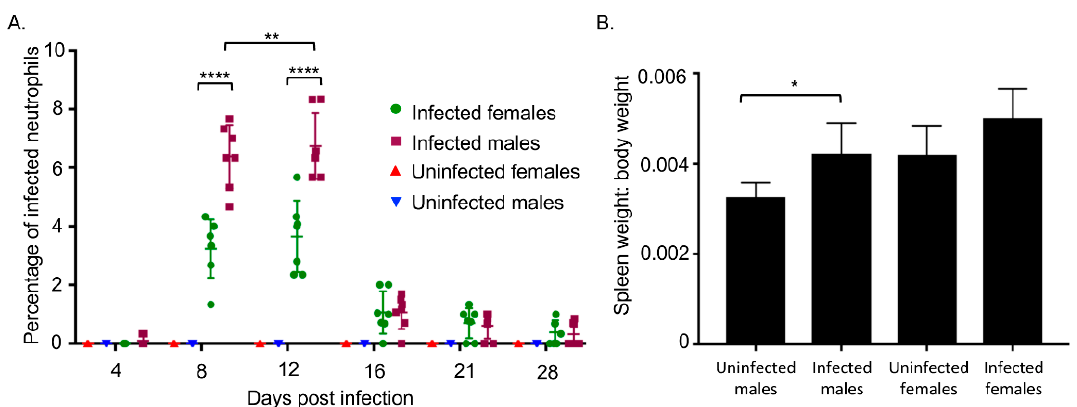
Figure 2. A. phagocytophilum infected male mice have higher percentages of peripheral blood neutrophils harboring morulae and greater degrees of splenomegaly than infected female mice. Male and female C57Bl/6 mice were intraperitoneally injected with A. phagocytophilum bacteria. ( A ) Peripheral blood smears were microscopically examined for neutrophils that contained morulae. Each dot corresponds to the mean percentage of infected neutrophils determined from counting a total of at least 300 neutrophils from three separate blood smears per mouse. Error bars correspond to the mean ± standard deviation of the percentages determined for all seven mice per group. Data are representative of two experiments with similar results; ( B ) On day 28, the mice were euthanized, the spleens were harvested, and the spleen-to-body weight ratios were calculated. Data are the mean ± standard deviation of the ratios determined from seven mice per group. Statistically significant ( * p < 0.05, ** p < 0.01, *** * p < 0.0001 values are indicated.